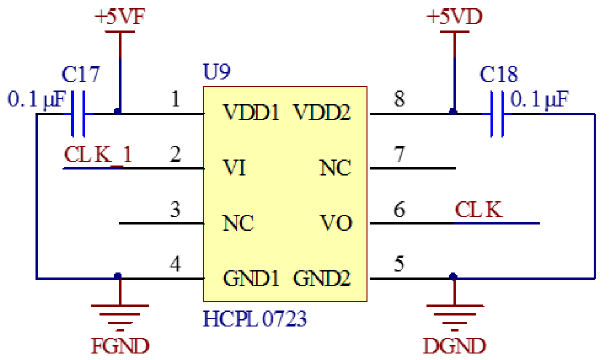
Figure 4. Block diagram of the FPGA master circuit.